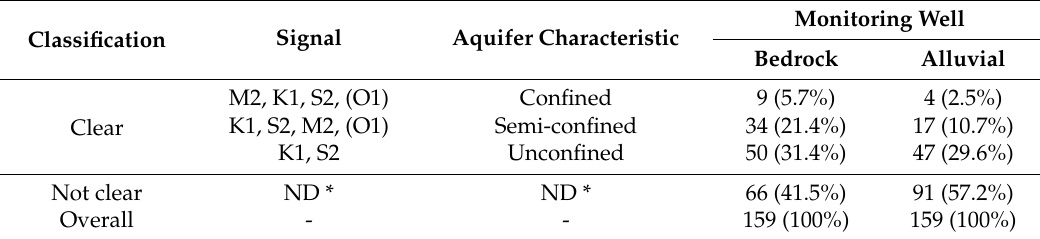
Table 3. Aquifer characterisation for alluvial and bedrock monitoring wells based on the results of the spectral analysis.